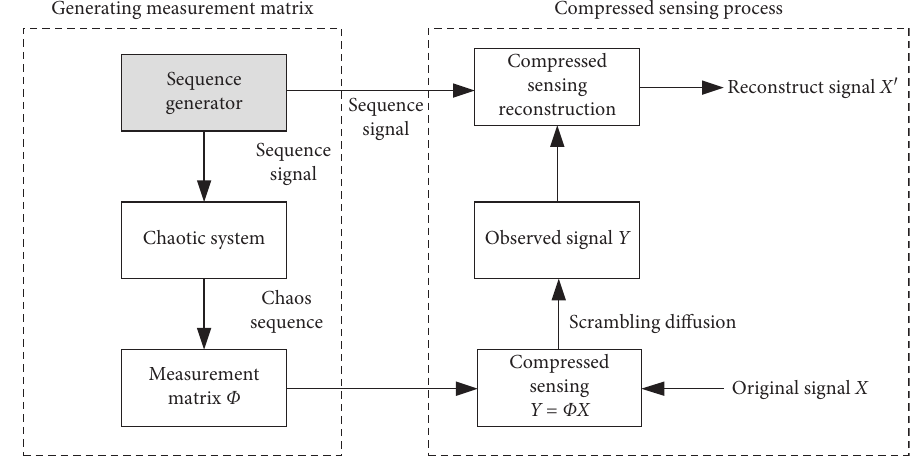
Figure 2: Parallel compression sensing encryption algorithm based on sequence generator.